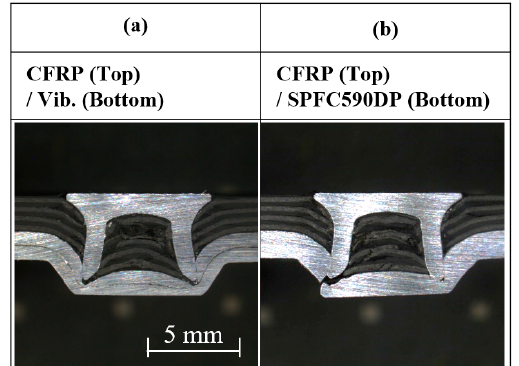
Figure 12. Comparison of the cross-sectional images of self-piercing riveted joint (fabricated by type A1 die) for di ff erent panel stacking con fi gurations. ( a ) CFRP (top) and vibration-damping steel (bot- tom) and ( b ) CFRP (top) and SPFC590DP (bo tt om).